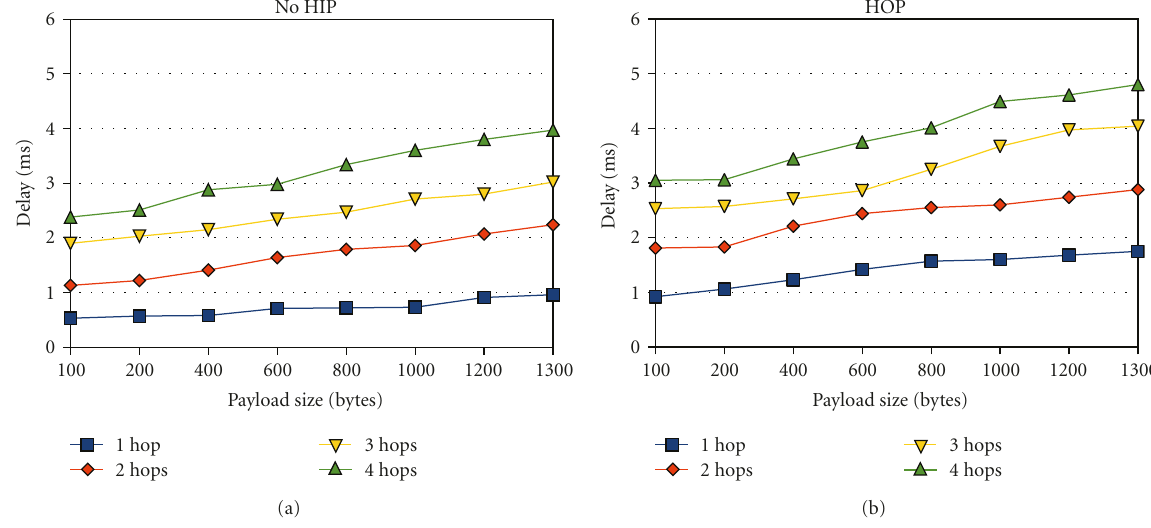
Figure 11: Round-trip time delay for di ff erent payload sizes in an insecure mode (a) and using HOP (b).